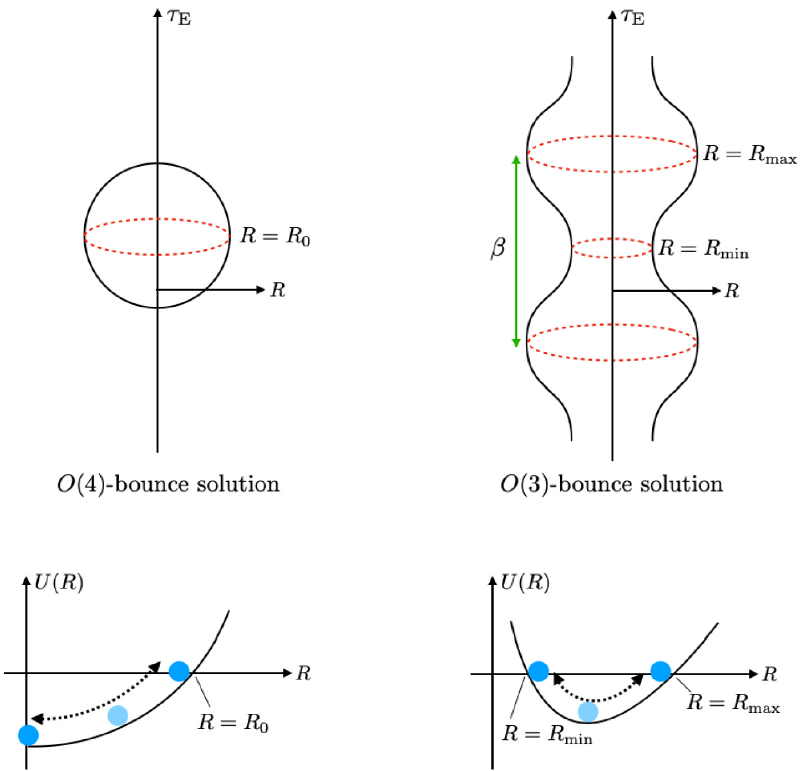
Figure 2 . Schematic pictures showing the O (4) and O (3)-bounce